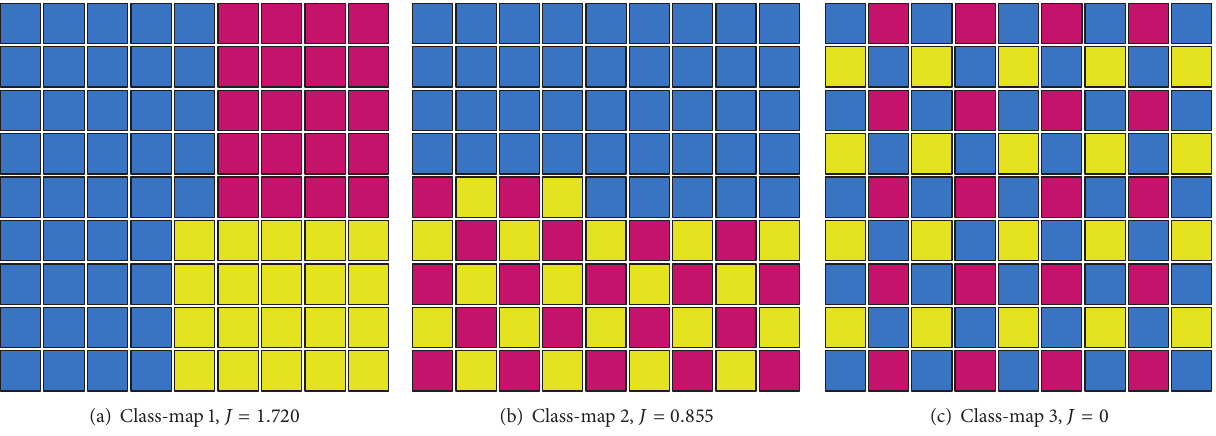
Figure 5: An example of different classes distribution and their corresponding 𝐽 .